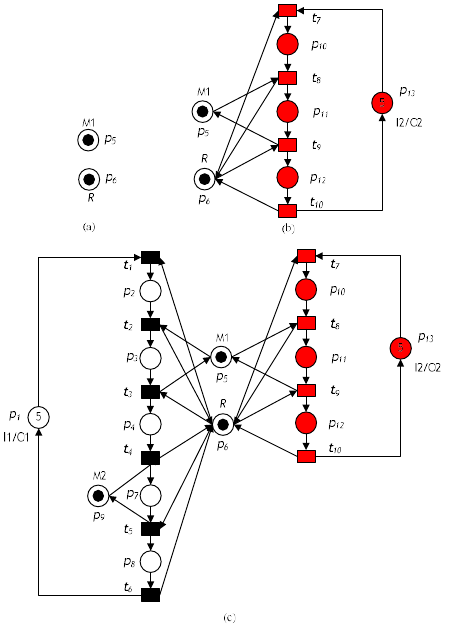
Figure 4. A reconfigured S 3 PR net by addition of new product. ( a ) Left hand side net L . ( b ) Right hand side net R . ( c ) A reconfigurable S 3 PR net ( N 2 , M 2o ).